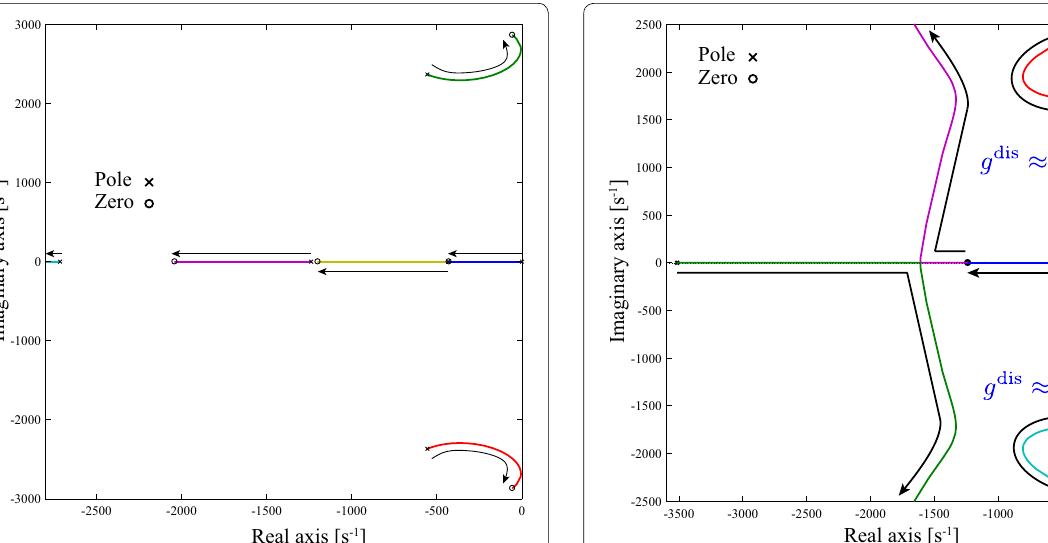
Fig. 12 Root locus for variation of DOB bandwidth g dis